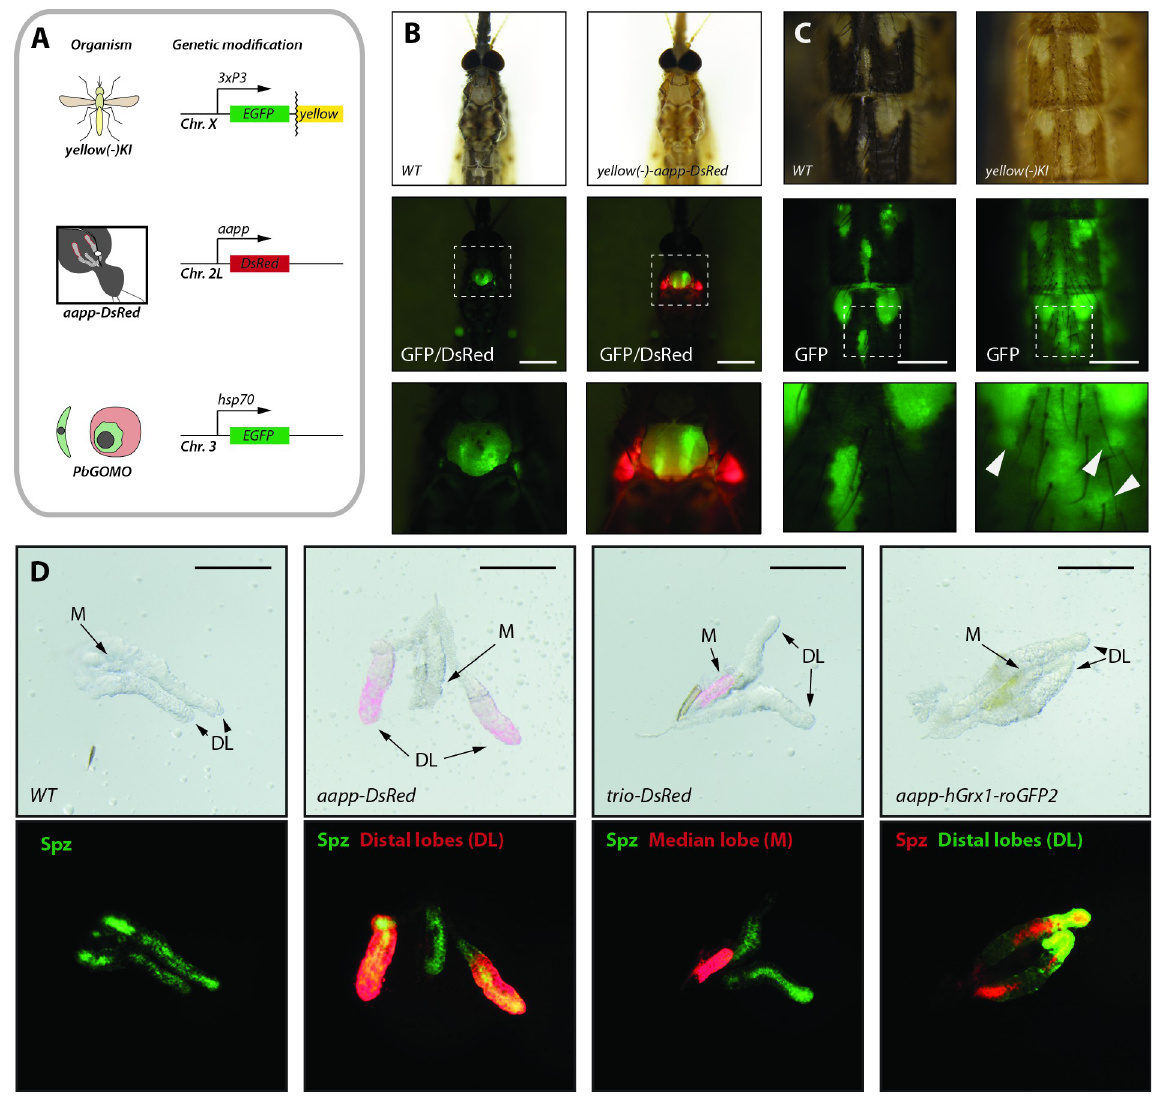
Fig 7. Yellow(-) and salivary gland reporter lines as tools for in vivo imaging. A) Genetic models used for in vivo imaging. Mosquitoes carrying the aapp-DsRed transgene were crossed with yellow(-)KI mosquitoes displaying reduced black pigmentation. Infections were carried out using the highly fluorescent P . berghei line Δ p230p-GFP constitutively expressing EGFP . B) Pigmentation phenotype and salivary gland- specific DsRed expression in P . berghei infected yellow(-)-aapp-DsRed and wild type ( WT ) mosquitoes. GFP -expressing sporozoites are displayed in green. Brightfield and DsRed signal of the same field of view. Note that the green dots in the lower thorax area represent hemolymph sporozoites trapped in the wing joints of mosquitoes. The images below show enlargements of the framed areas in the images above. Scale bar: 0.5 mm. C ) Images of the abdomen of infected yellow(-)KI and wild type ( Ngousso ) mosquitoes. Brightfield and GFP expression of the same field of view. The images below show enlargements of the framed areas in the images above. Note the better light transmission in the abdomen of the yellow(-)KI mosquito. White arrows point towards oocysts visible through more pigmented areas of the cuticle of yellow(-)KI mosquitoes. Scale bar: 250 μ m. D) Images of salivary glands highly infected with P . berghei . Wild type ( WT ), aapp-DsRed and trio-DsRed have been infected with GFP expressing P . berghei ( Δ p230p-GFP ) while aapp-hGrx1-roGFP2 mosquitoes were infected with mCherry expressing P . berghei ( Δ p230p-mCherry ). M = median lobe; DL = distal lobes. Scale bar: 250 μ m. EGFP expression in the ovaries is likely due to the endogenous promoter activity of the yellow promoter. However, no significant increase in green fluorescence was observed at the throat area where the salivary glands localize compared with WT, suggesting that imaging of GFP- positive parasites would be feasible.